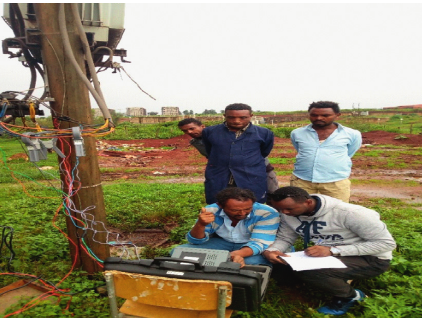
Figure 2: Photo during measurements.